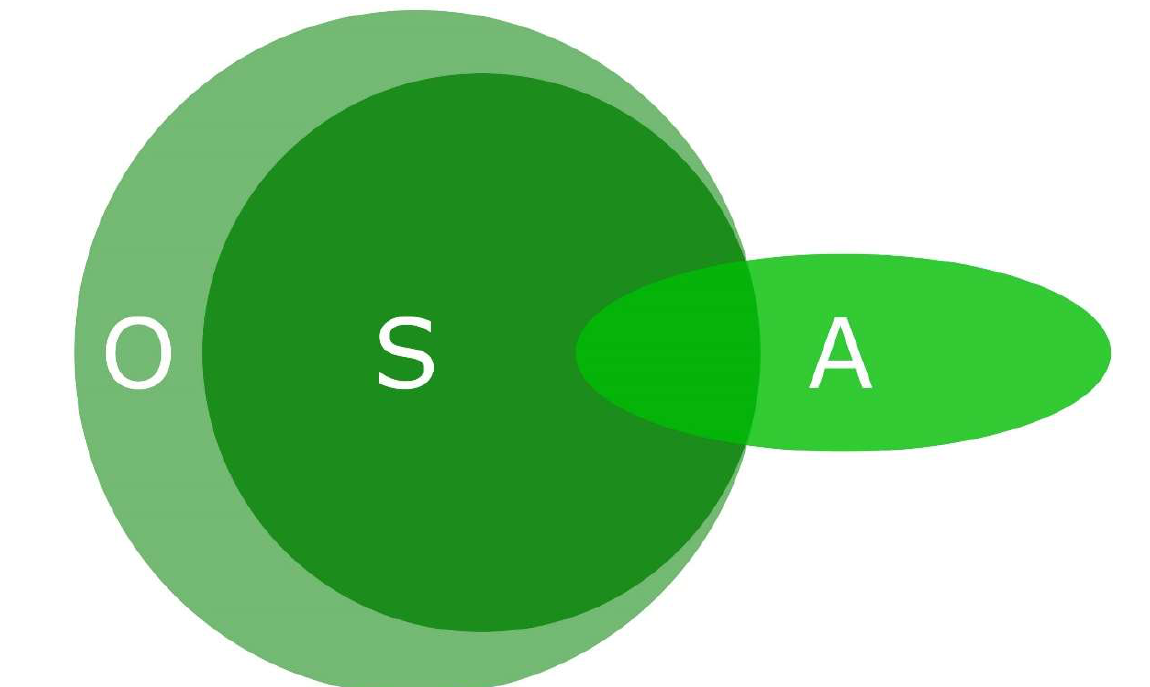
Figure 1. The occurrence-source-archaeological site (OSA) model. Occurrence (O): available siliceous rock resource without human utilization; Source (S): an occurrence of a siliceous rock used by humans, but without traces of human activity at the site; Archaeological site (A): locality with human activity related to raw material acquisition or use. (CAD by N. Faragó). Figure 1. Le modèle gîte-source-site archéologique (OSA). Gîte (O): resource de roche siliceuse qui est disponible mais inutilisée par les humains; Source (S): gîte d’une roche siliceuse utilisé par les humains mais sans activités sur place; Site archéologique (A): localité avec activité humaine liée à l’acquisition ou l’utilisation de matières premières. (DAO: N.